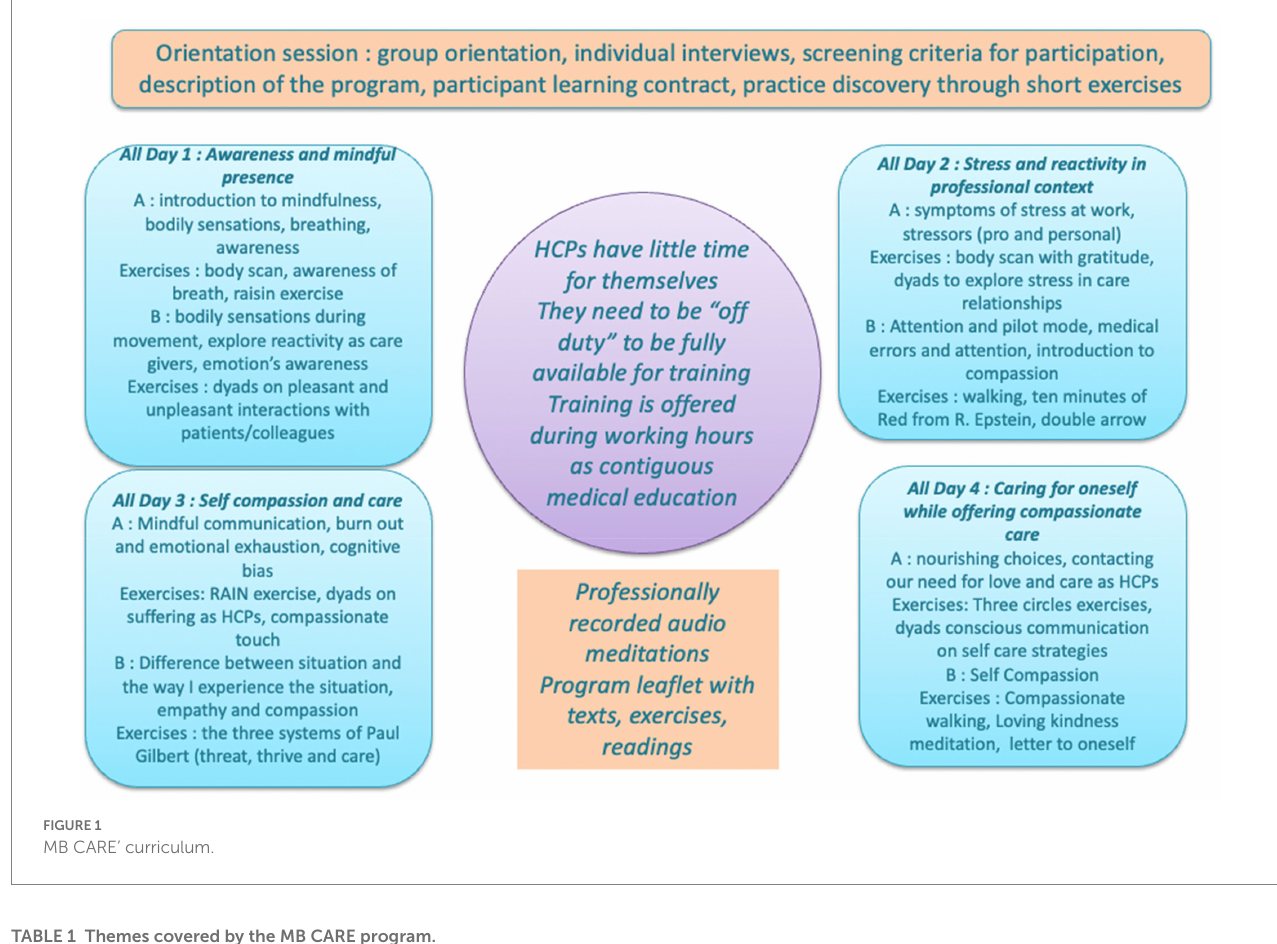
TABLE 1 Themes covered by the MB CARE